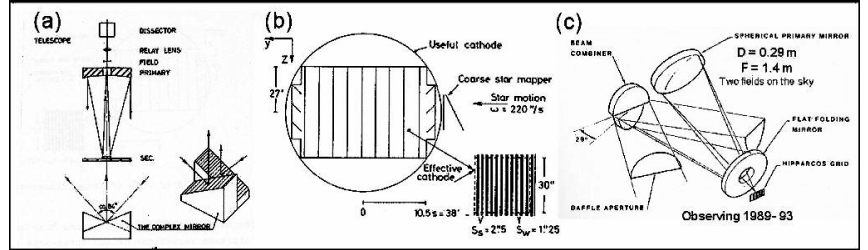
Fig. 3. (a) and (b): Hipparcos design by mid 1976. (c): When launched in 1989, the telescope was very different, a folded Schmidt system. The slit system and detectors were quite similar to (b), but the Tycho star mapper slits were implemented. Source: see